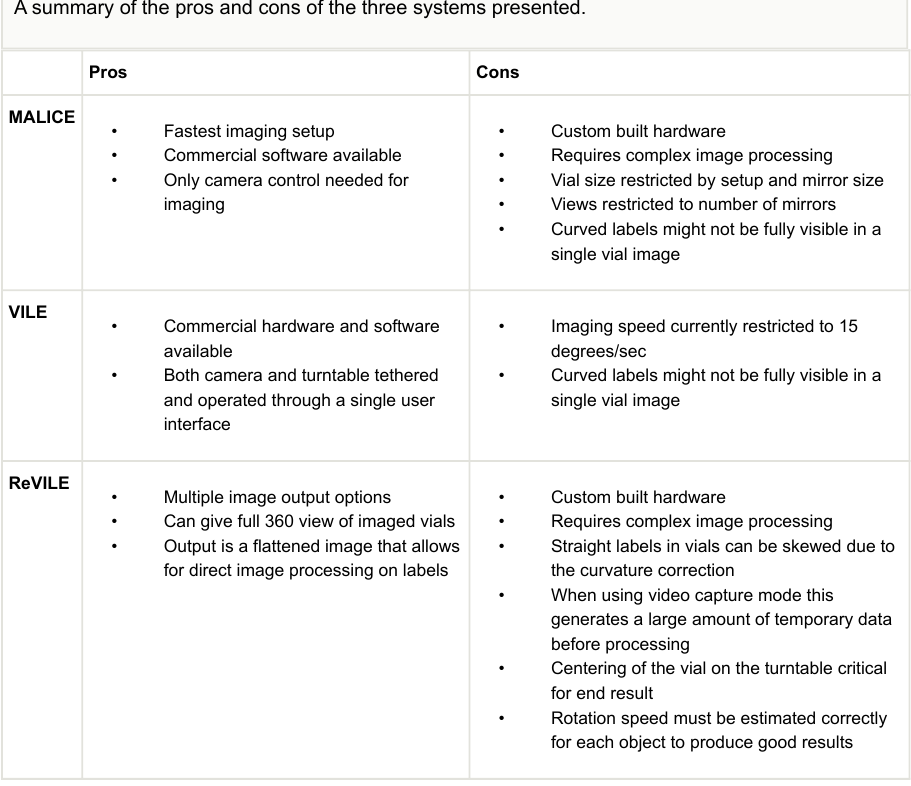
Ahead of the curve: three approaches to mass digitisation of vials with